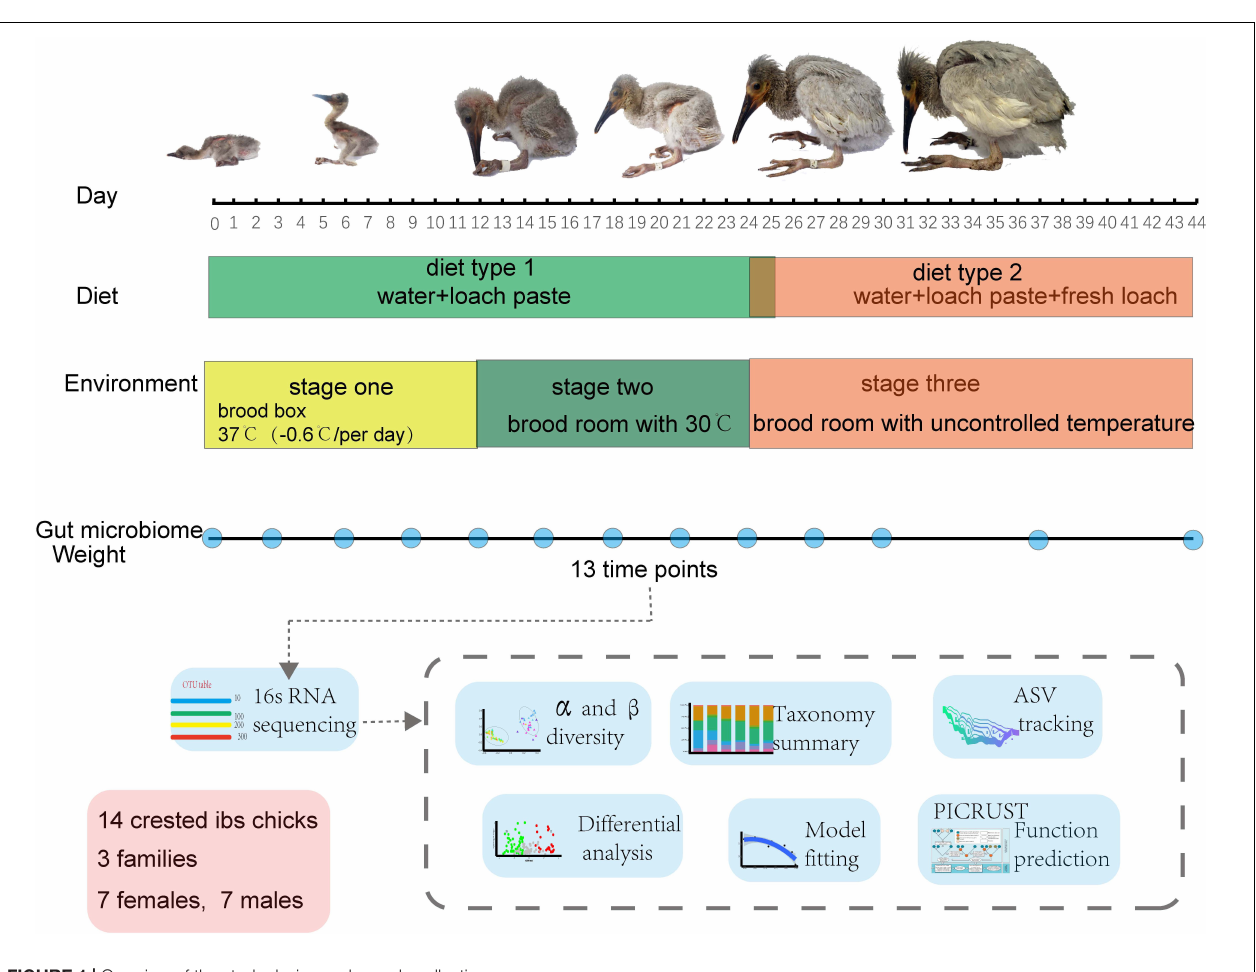
FIGURE 1 | Overview of the study design and sample